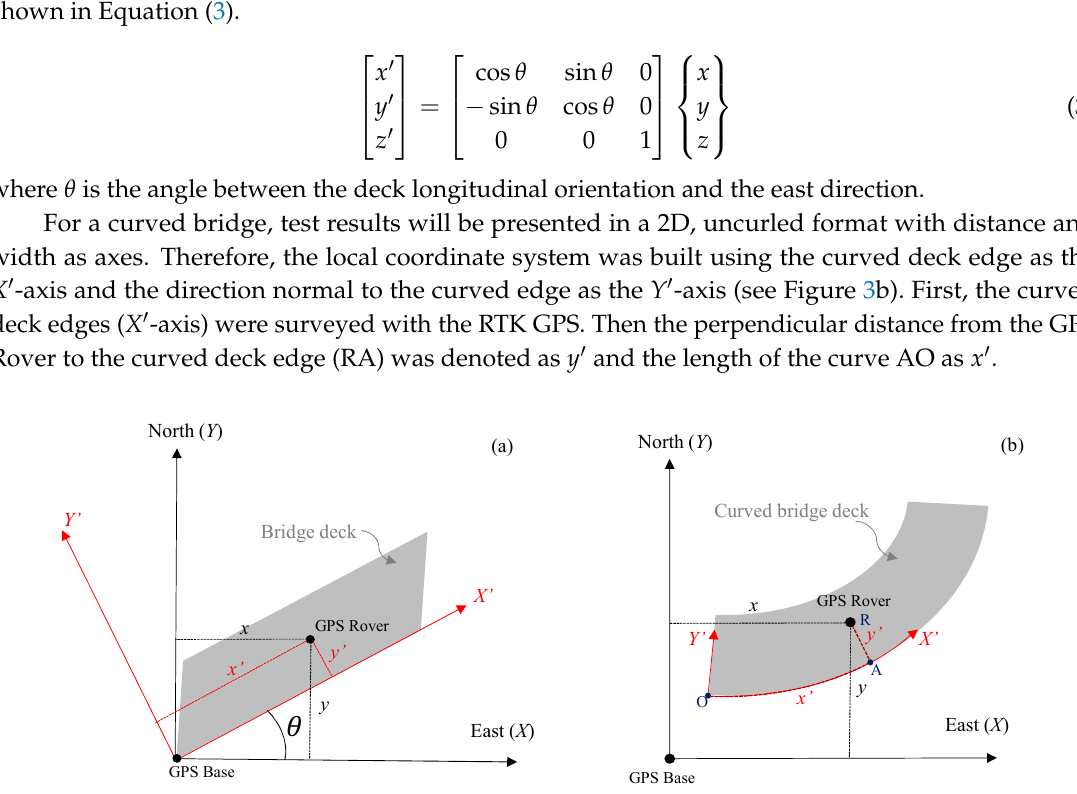
Figure 3. Positioning coordinates transformation on ( a ) the straight bridge and( b ) the curved